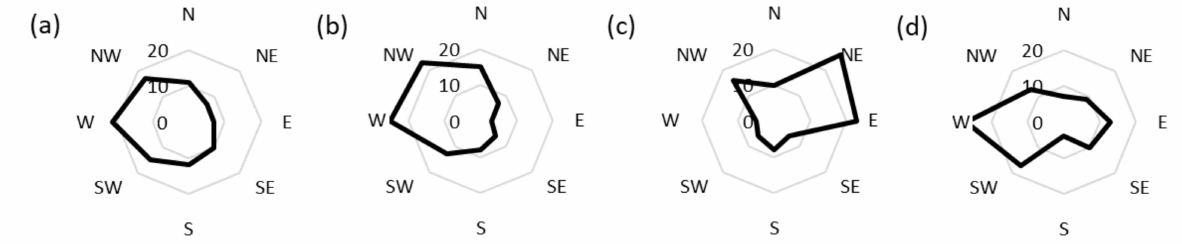
Figure 11. Rose diagrams of the frequencies (%) of wind directions during study periods P1 ( a ), P2 ( b ), P3 ( c ), and P4 ( d